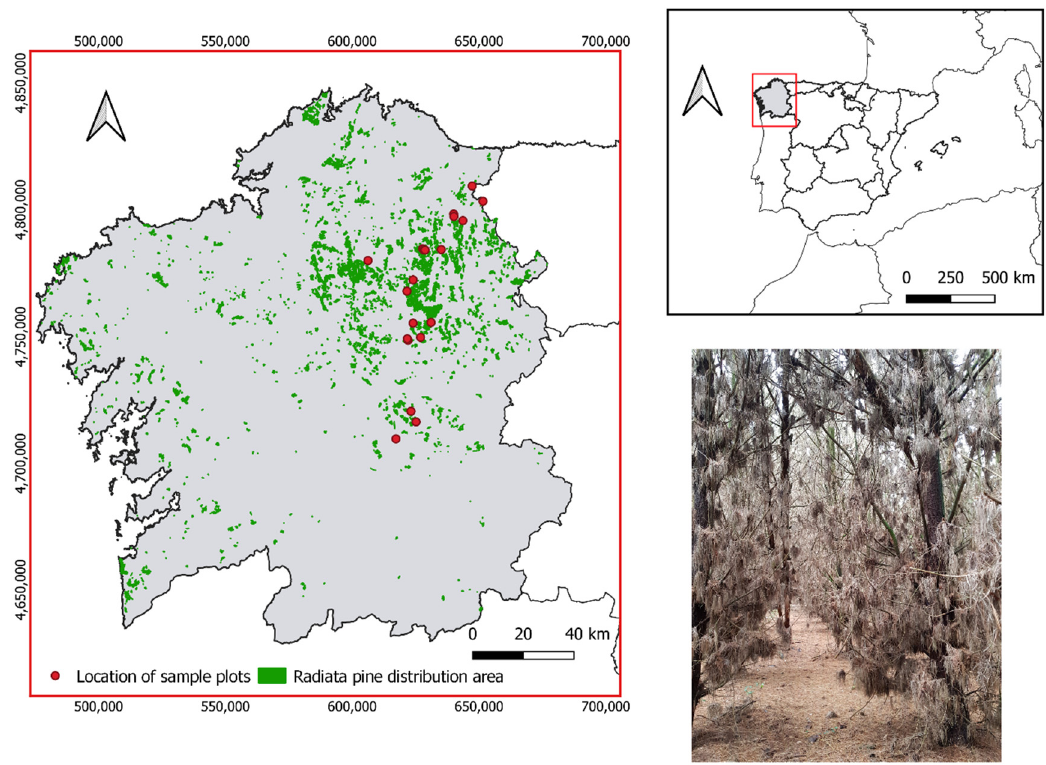
Figure 1. Geographical location of Pinus radiata stands in Galicia and of the 20 plots included in the study ( left ). View of one of the study plots ( lower right study ( left ). View of one of the study plots ( lower right ).